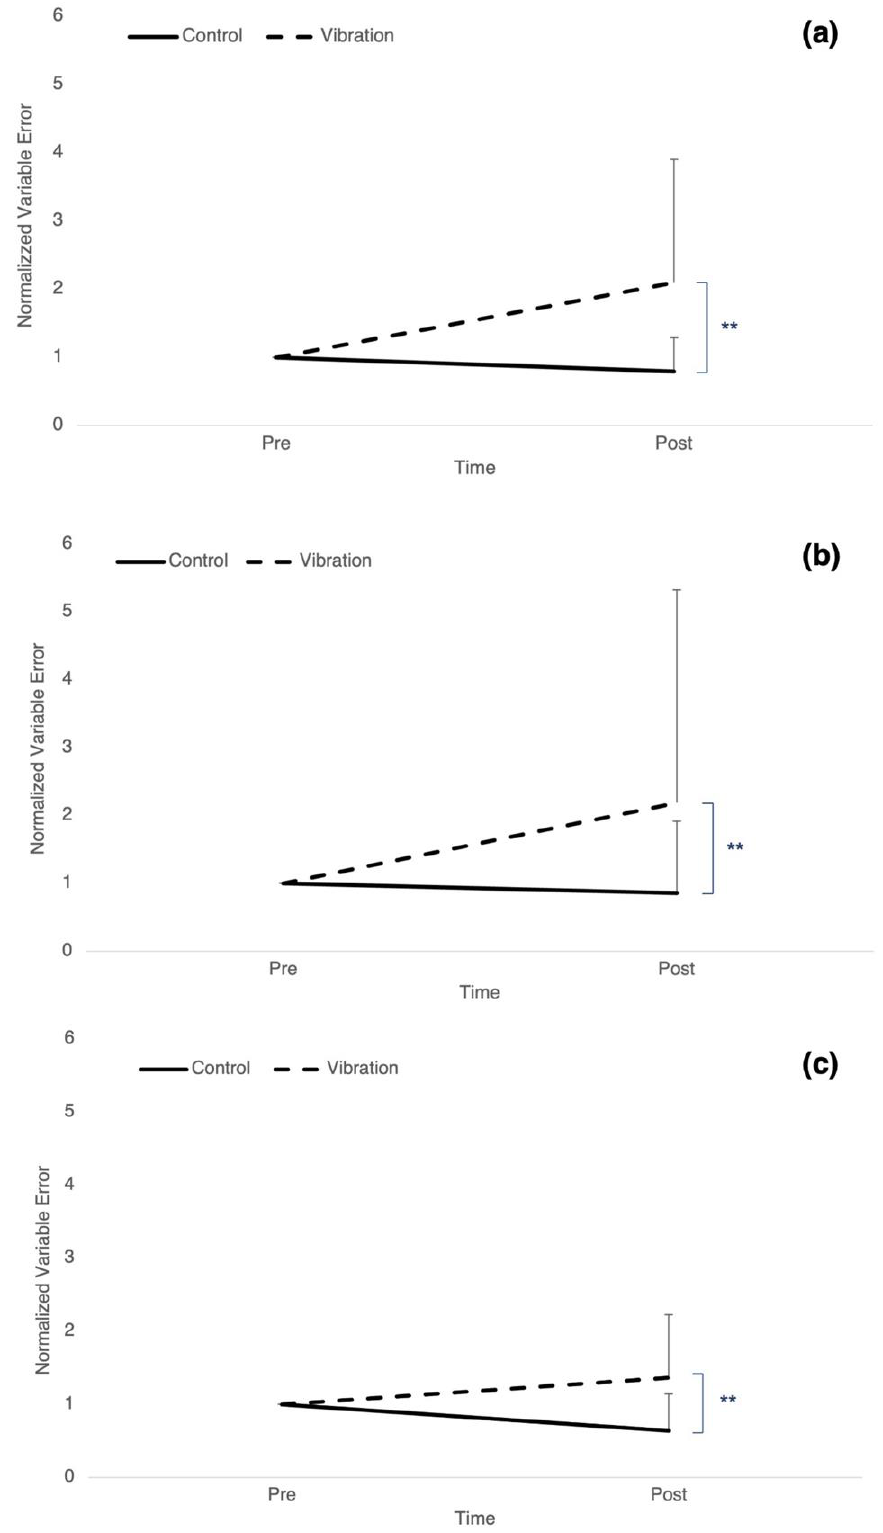
Figure 3. Normalized mean variable error for controls (solid line) and vibration group (dashed line). Post measures have been normalized to baseline scores. ( a ) target angle 1 between 80–90 degrees. ( b ) target angle 2 between 90–100 degrees. ( c ) target angle 3 between 100–110 degrees. Error bars represent SD. (** p ≤ 0.01).